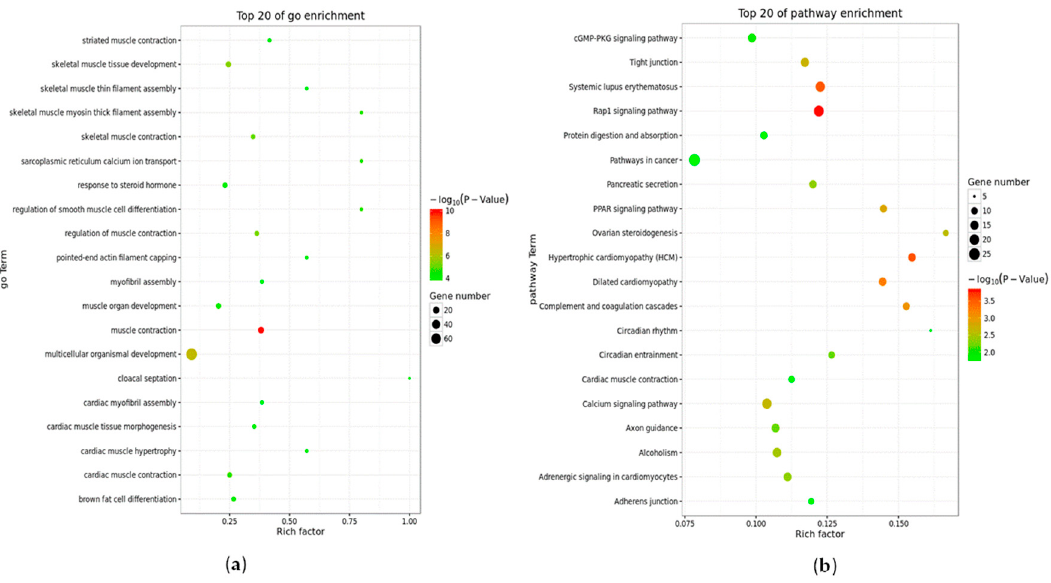
Figure 3. Heatmap for the hierarchical cluster analysis of differentially expressed genes (DEGs) between samples. Control1–3 is to add the recombinant adenovirus AD-NC sample; Case1–3 is to add the recombinant adenovirus AD-Rybp sample. Red represents upregulated genes and green represents downregulated genes.